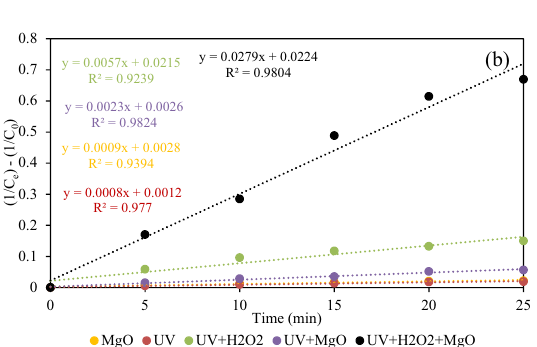
Figure 13. The degradation of DEX under MgO, UV, UV/H 2 O 2 , UV/MgO, and UV/H 2 O 2 /MgO processes based on a pseudo-second-order model.